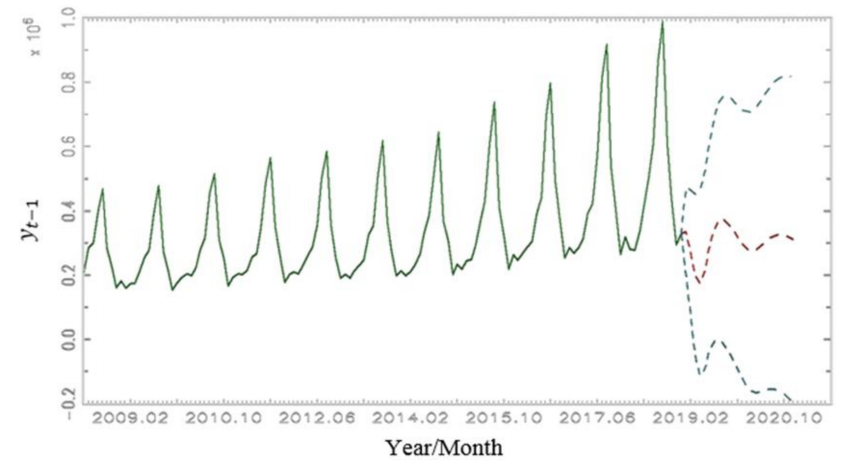
Figure 2. Forecast of tourist arrivals for 24 months. Source: Authors’ calculations. Note: Data vector is from January 2008 to December 2018; upper, middle, and lower forecast levels are from